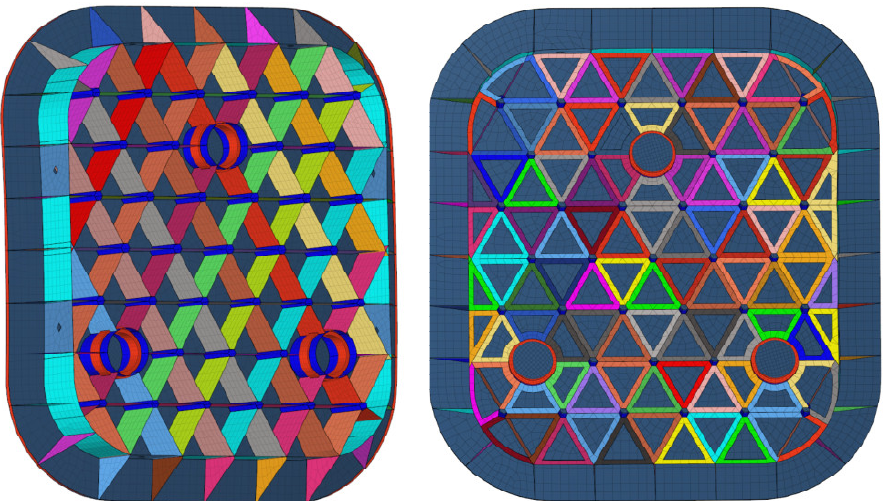
Figure 6. Lightweight ribs grouped according to their geometric position characteristics and marked with the same color. Table 2. The performance and constraints of the mirror assembly under different operating